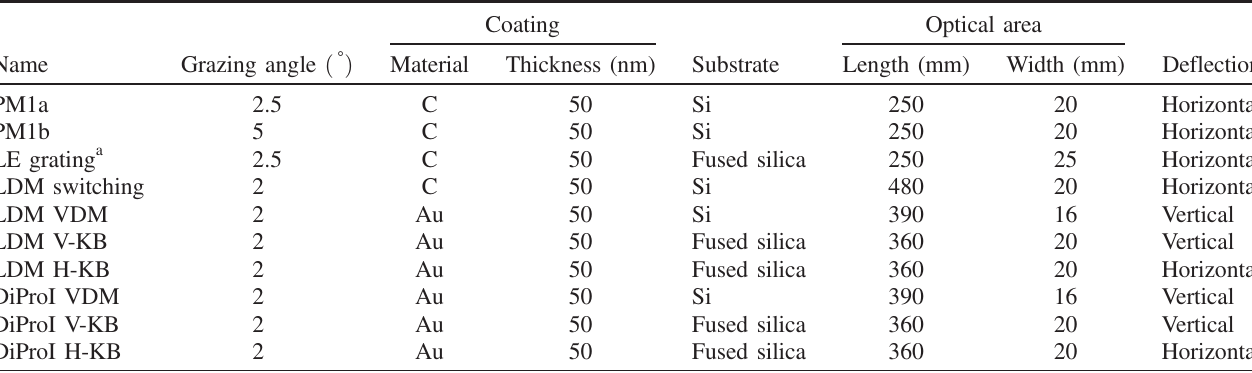
TABLE IV. Main optical parameters and physical description of the mirrors and grating of PADReS. Coating